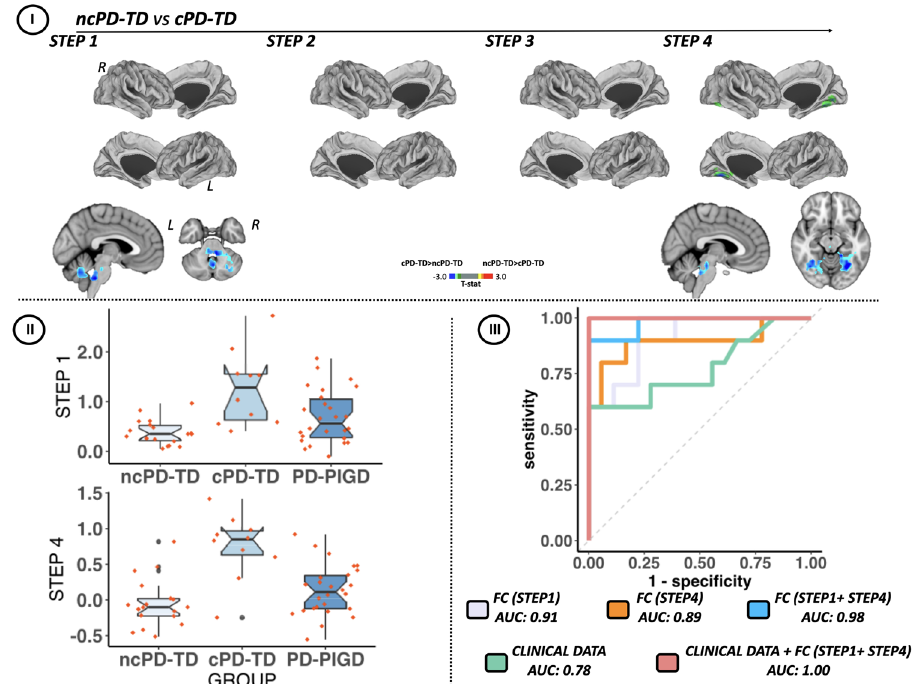
Fig. 3 Differences in stepwise functional connectivity of the cerebellar seed region between PD-TD converters and non-converters to PD- PIGD subtype in a 4-year follow-up. I Cortical maps represent the signi fi cant differences in stepwise functional connectivity values between PD-TD subtypes. Statistical analysis was adjusted for age and gender. Results were corrected for multiple comparisons using a threshold-free cluster enhancement method combined with nonparametric permutation testing at p -value < 0.05 FWE-corrected. Color bars show the t-statistic applicable to the image. II Functional connectivity of altered network in PD-TD converters to PIGD subtype. Box plot of functional connectivity of altered brain network is shown for patient group. The red horizontal line in each box plot represents the median, the two lines just above and below the median represent the 25th and 75th percentiles, whiskers represent the minimum and maximum values, and all the dots outside the con fi dence interval are considered as outliers. III ROC analyses for characterization of patient at high risk of conversion to PIGD subtype. The predictive accuracy of direct (one-link-step) and indirect (four link-steps) functional connectivity and/or clinical data for the conversion to PIGD subtype was evaluated by area under the curve of ROC analysis. AUC, area under the curve; c, converters; CI, con fi dence interval; FC, functional connectivity; HC, healthy controls; L, left; nc, non-converter; R, right; ROC, receiver operating characteristic; PD-TD, Parkinson ’ s Disease tremor